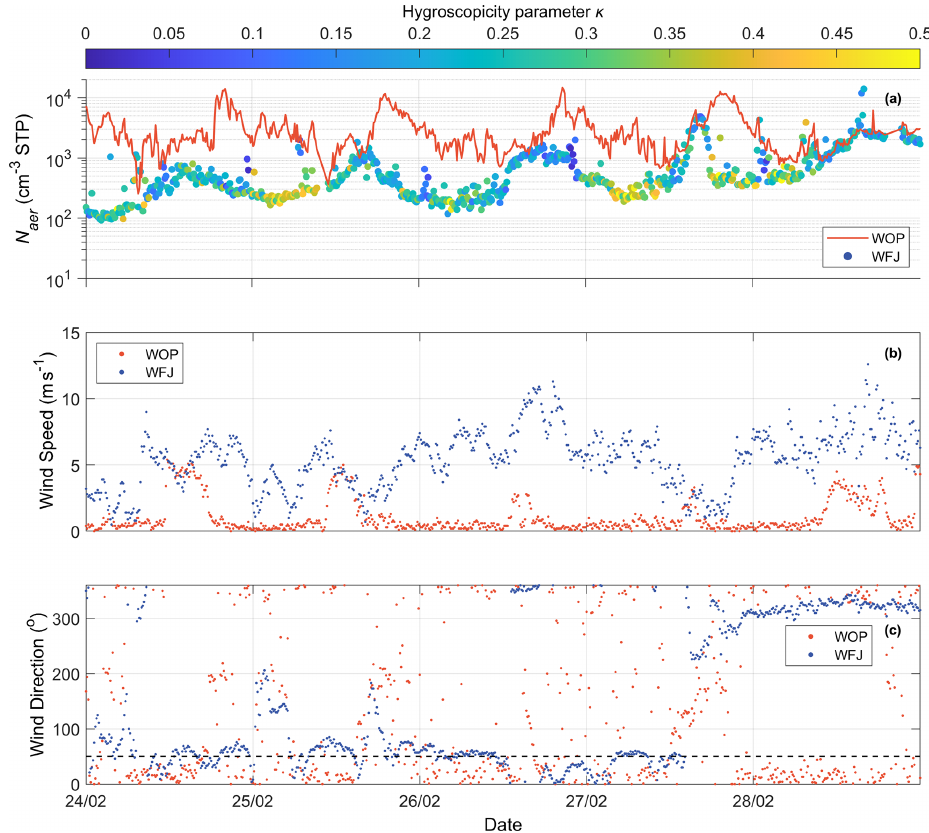
Figure 1. (a) N aer under standard temperature and pressure conditions (cm − 3 STP) at WOP (orange line) and at WFJ (circles colored by κ ), (b) wind speed (ms − 1 ), and (c) wind direction (in degrees) obtained from the MeteoSwiss observation stations at WFJ (blue dots) and Davos (orange dots) between 24 and 28 February 2019. The black dashed line indicates the relative direction of WOP to WFJ. Each day is referenced to